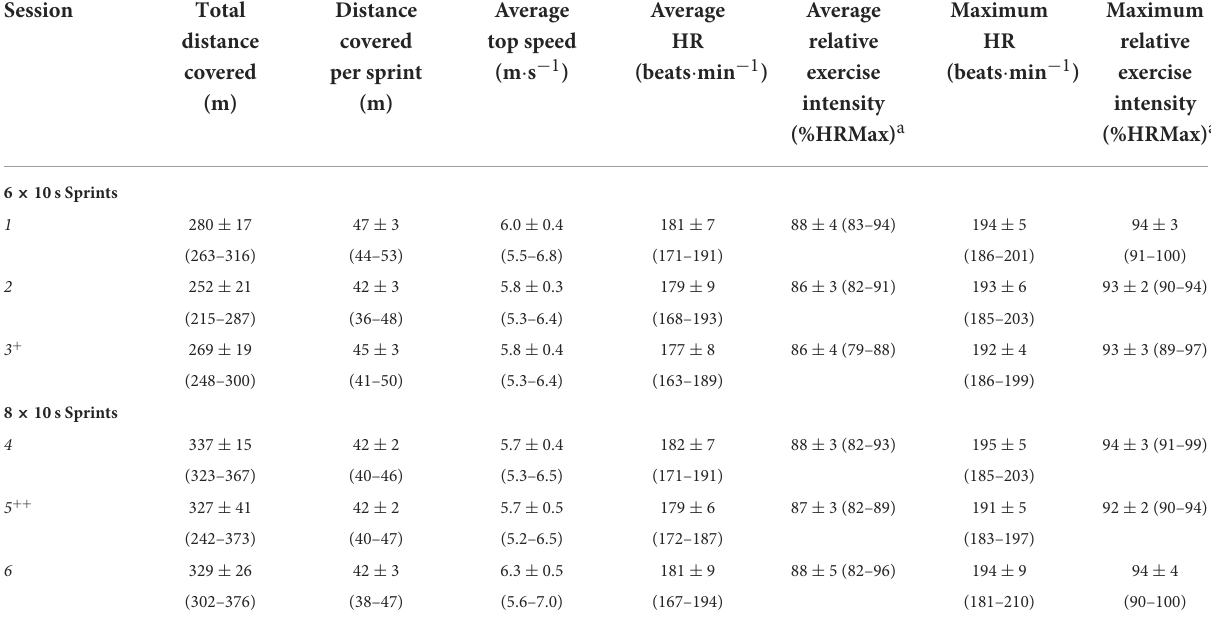
TABLE 2 Average external and internal training load for each session across the intervention period. Session Total